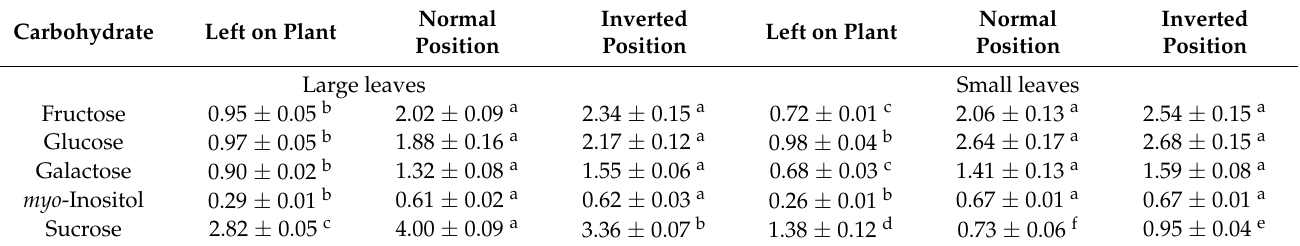
Table 3. Carbohydrate content (mg/g DW) in K. blossfeldiana leaves on the plant and in leaves detached from the plant and kept for 4 days in the normal (natural) position or kept for 4 days in the inverted position. Mean results in rows ± standard deviation followed by the same letter were not significantly different ( p < 0.05) according to Tukey’s